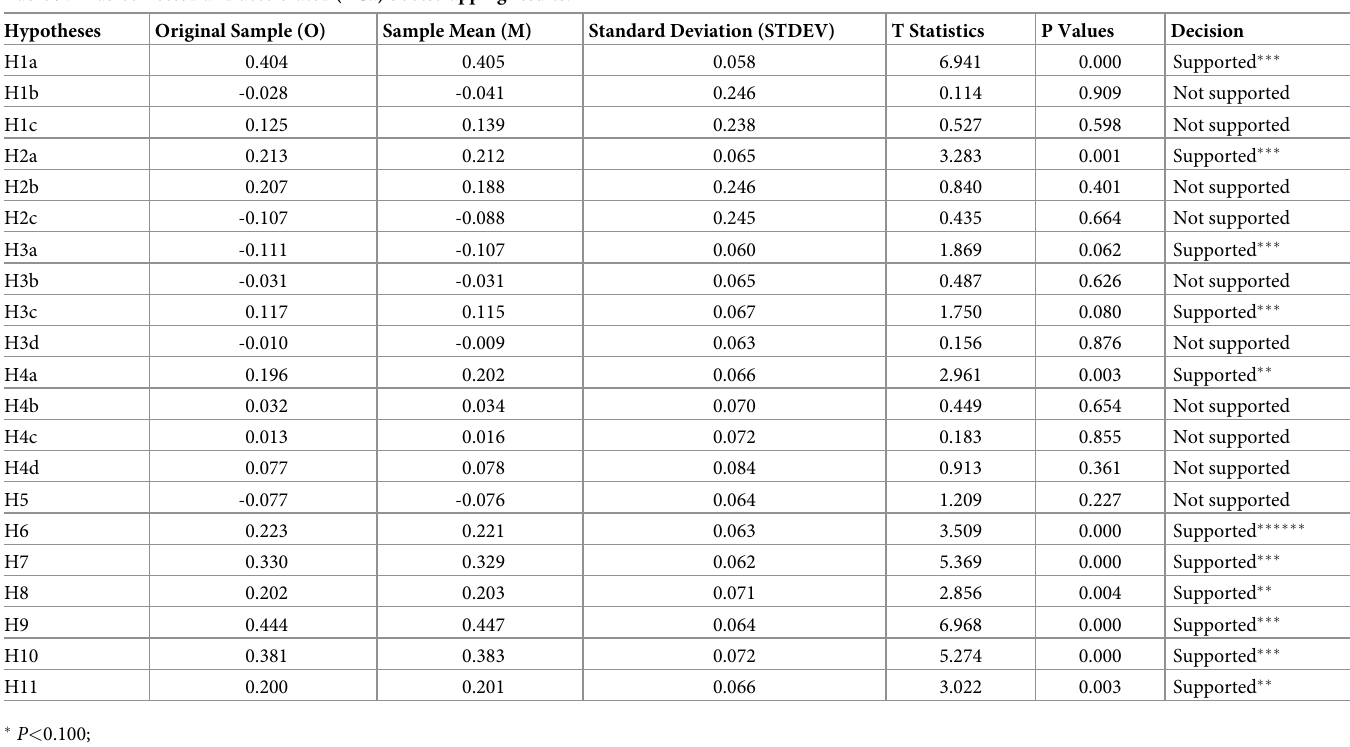
Table 9. Bias-corrected and accelerated (BCa) bootstrapping results.